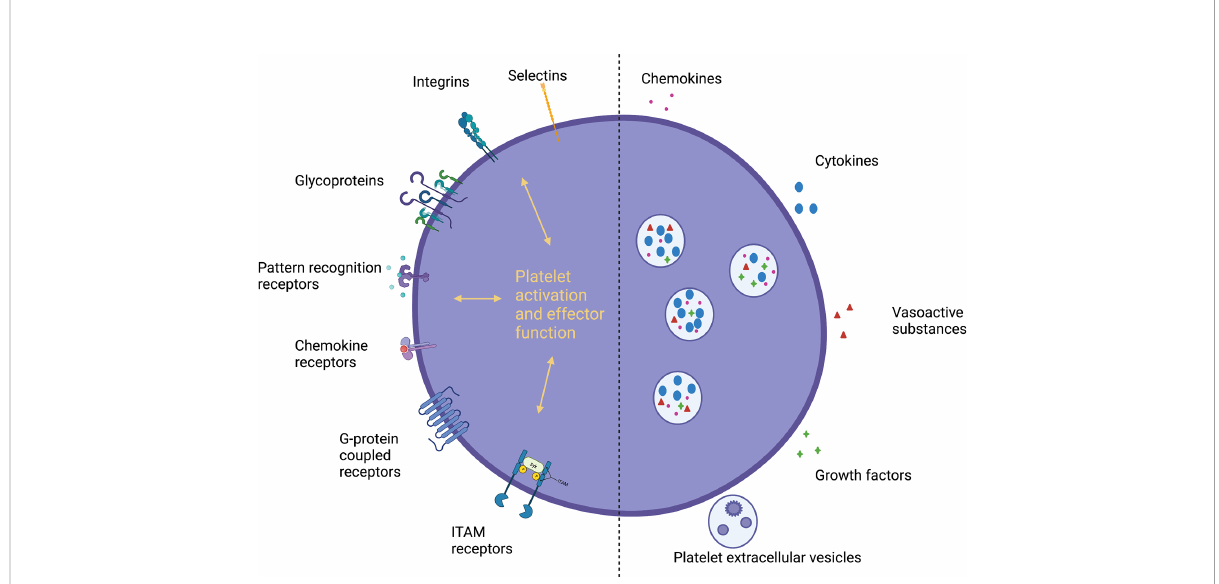
FIGURE 1 Platelet receptors and secreted mediators. Platelets express a diverse range of receptors and a large proteasome, secreting a variety of soluble mediators, facilitating direct and indirect interactions with immune cells, the endothelium and the extracellular matrix. Pattern recognition receptors, PRRs; G-protein coupled receptors, GPCRs; Immunoreceptor tyrosine-based activation motif, ITAM; Platelet-derived extracellular vesicles, PEVs